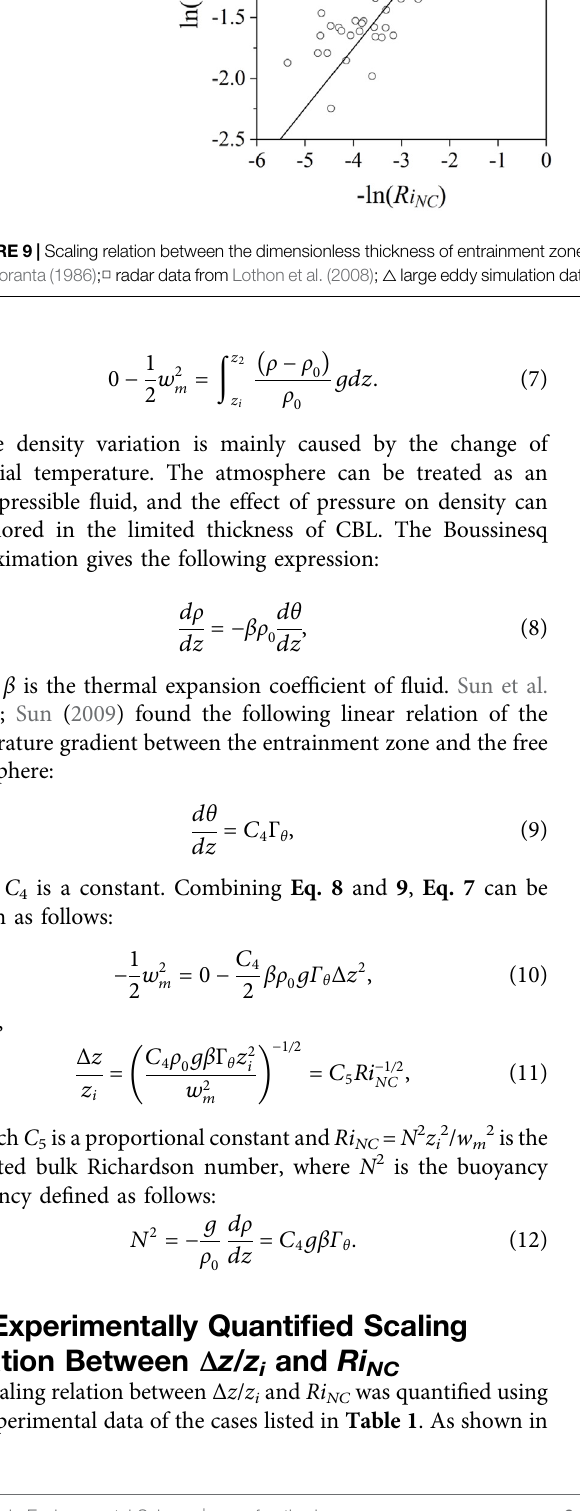
Frontiers in Environmental Science |